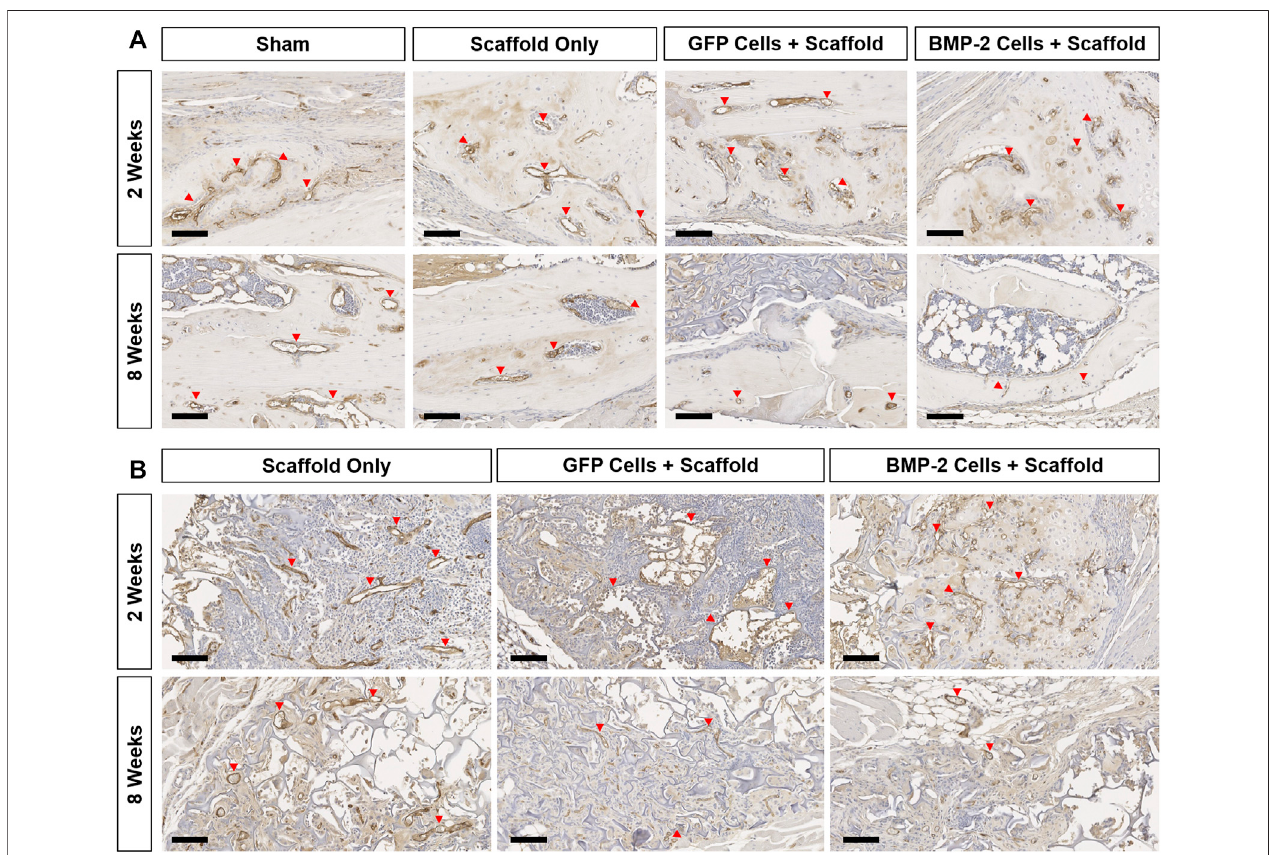
FIGURE 6 | Representative endomucin (brown) staining of the vasculature within the non-union and scaffold sites of all the groups at 2 and 8 weeks postimplantation. (A) 10ximages ofthewoven bone at 2 weeksshow extensive vessel staininginall thegroups (redarrows).Comparatively, at8 weeks, vessel staining wasgreatlyreducedinallgroups. (B) Endomucinstainingwithinthescaffoldshowedvasculatureassociatedwithnewboneformationatboththetimepointsinallgroups treated with a scaffold ± cells. Scale bars denote 100 μ